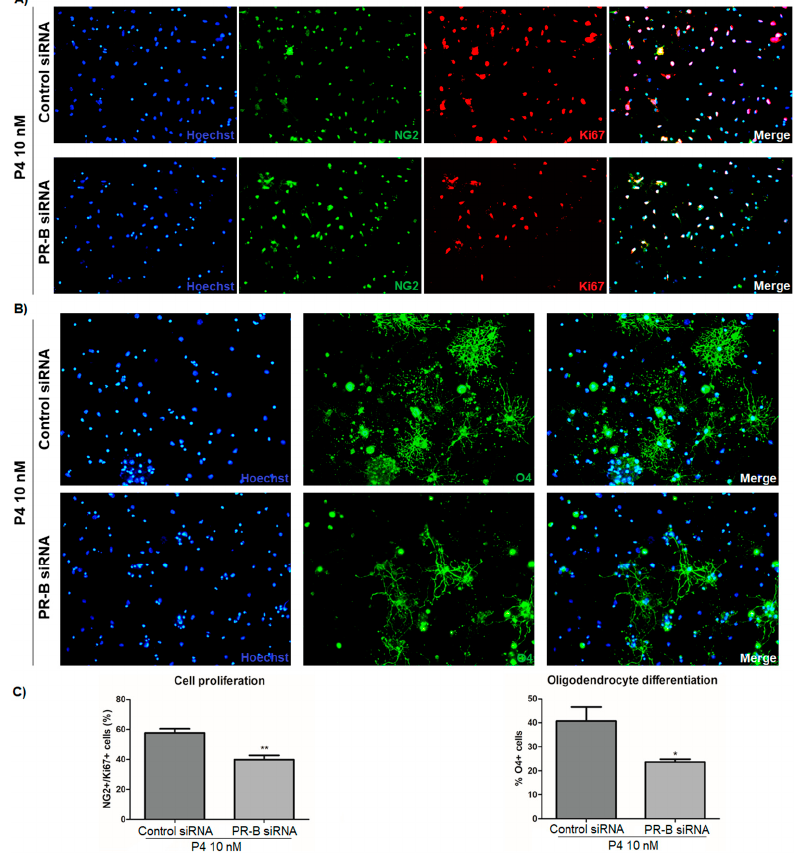
Figure 7. The silencing of PR-B blocks the oligodendrogenic effects of progesterone. ( A ) NG2/Ki67 and ( B ) O4 immunofluorescence in OPC transfected with a control siRNA or with a PR-B siRNA and treated for 3 days with P4 (10 nM). ( C ) Graphs derived from the percentage of NG2/Ki67 and O4-positive cells observed in the immunofluorescence. Results are expressed as the mean ± S.E.M. n = 3; * p < 0.05 and ** p < 0.01 vs. control siRNA.